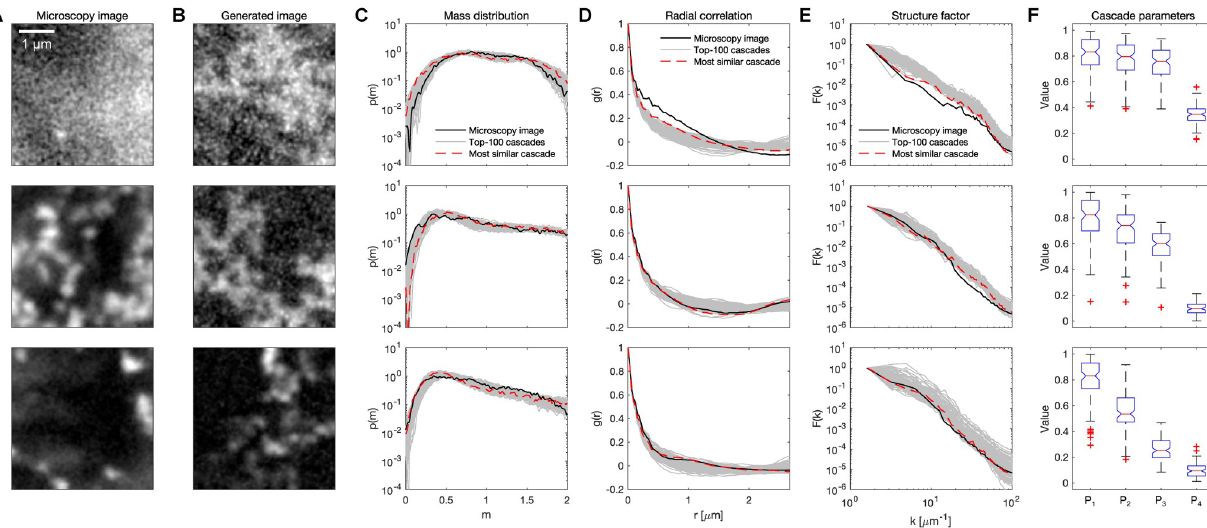
Fig 4. Multiplicative cascades can be empirically adjusted to reproduce euchromatin patterns observed in microscopy images. A) Example microscopy images that were used as targets in the adjustment of multiplicative cascades. Intensities are scaled to the range of each image. Raw images were blurred with a Gaussian filter (kernel width 35 nm). B) Generated microscopy images with highest similarity to the microscopy images (64-by-64 pixels, σ 1 = 80 nm, λ = 1, σ 2 = 35 nm, images are from the most similar cascade as chosen by mass distribution and correlation function). C) Mass distributions of the microscopy images, of the most similar generated images, and of the top-100 cascades with highest similarity of mass distribution functions. The top-100 cascades were extracted from an ensemble of 10,000 proposed cascades with randomly assigned parameters. D) Pair-wise radial correlation functions for the microscopy images, the most similar generated images, and the top-100 cascades. E) F ( k ) curves for the microscopy data, fit of the microemulsion F ( k ) function, F ( k ) curve of the raw concentration profiles from the most similar multiplicative cascades, and from the blurred concentration profile from that cascade. F) Box-plots of the cascade parameters of the top-100 cascades. The values P 1 to P 4 were sorted in descending order before plotting. Note that probabilities are randomly assigned in each sub-partitioning step, so that this sorting did not affect the image generation